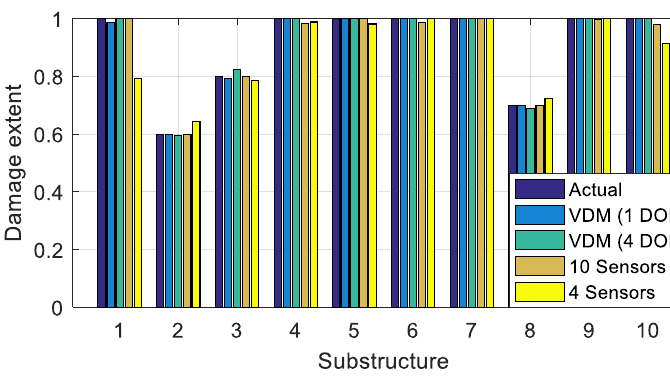
Figure 27. Comparison of damage identification results.